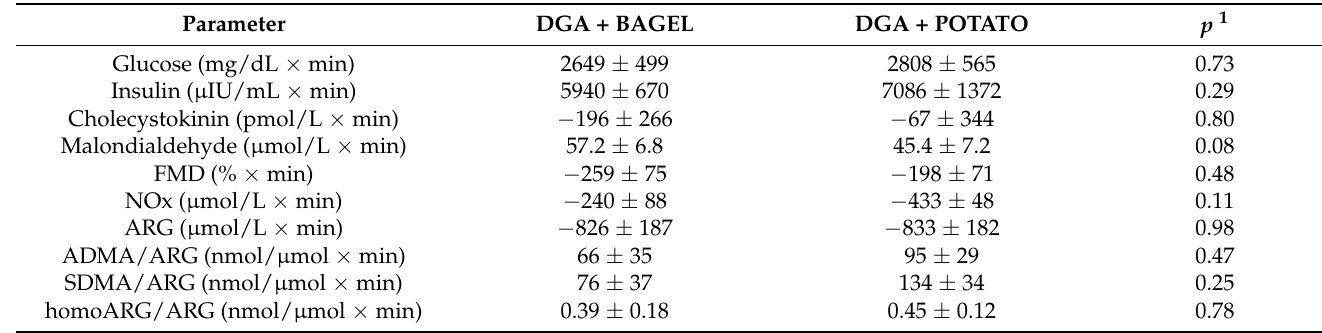
Table 4. AUC 0–120 min for cardiometabolic health in MetS persons who were provided a DGA-based diet containing a daily serving of bagel (DGA + BAGEL) or potato (DGA + POTATO) for 2 weeks prior to receiving an oral glucose tolerance test and assessing postprandial responses at 30 min intervals for 2 h 1,2